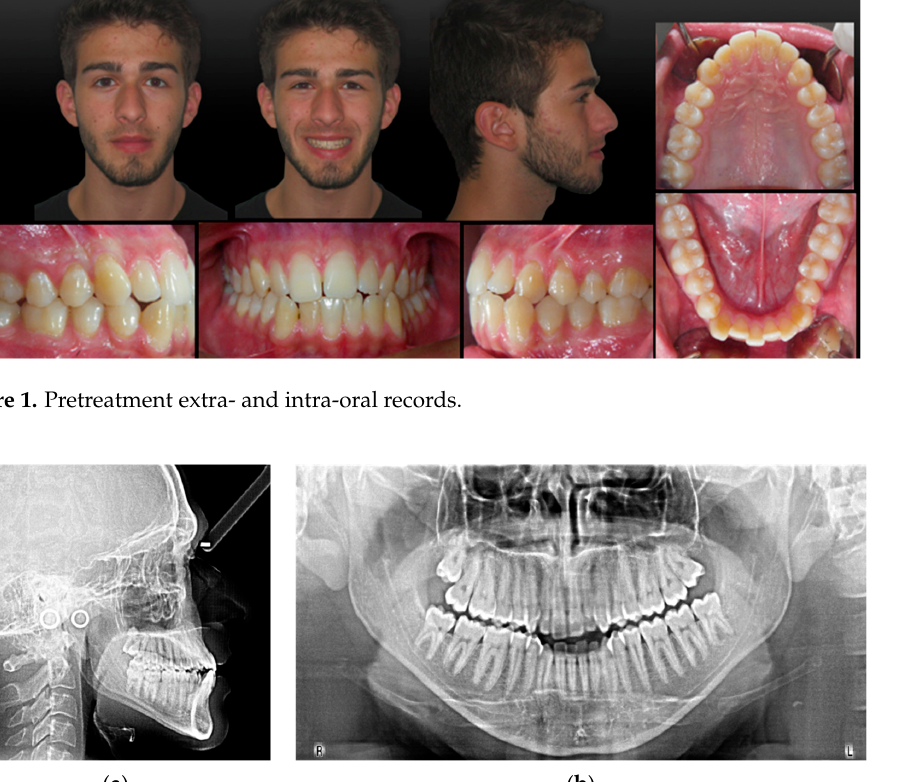
Figure 2. Lateral cephalogram ( a ) and panoramic radiograph ( b ) at the beginning of the treatment.